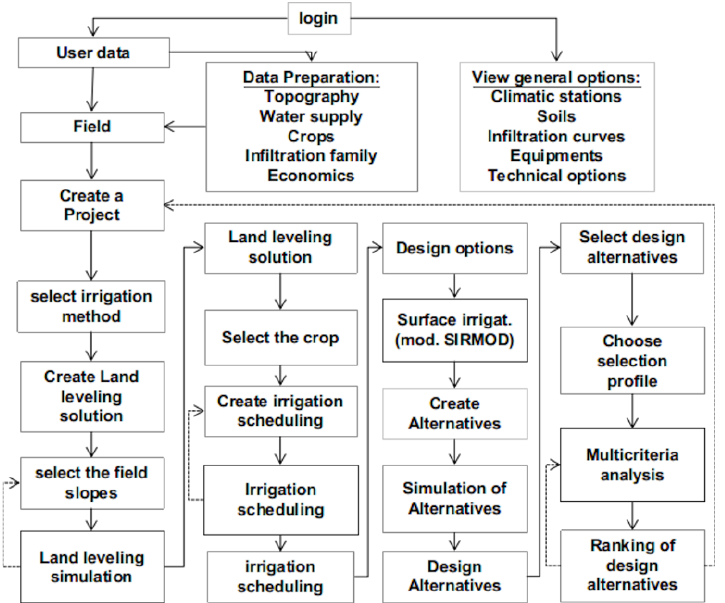
Figure 3. Data and simulation